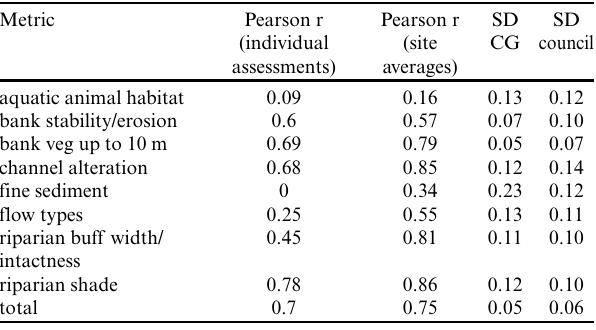
Table 3 . Correlations (as Pearson r correlation coefficients) between community groups (CG) and regional councils (council) for physical habitat assessment and the eight metrics that compose it. Columns 4 and 5 refer to the average of standard deviations (SD) of repeated measurements at individual sites, averaged over all